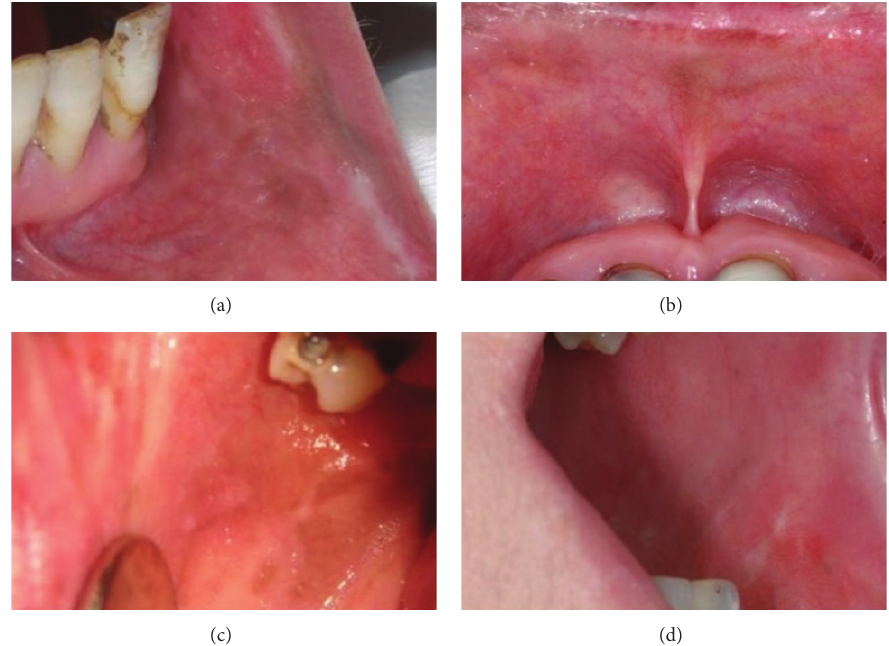
Figure 2: The healing process occurred without any complication and the entire pigmentation had been cleared (14th day postoperatively).